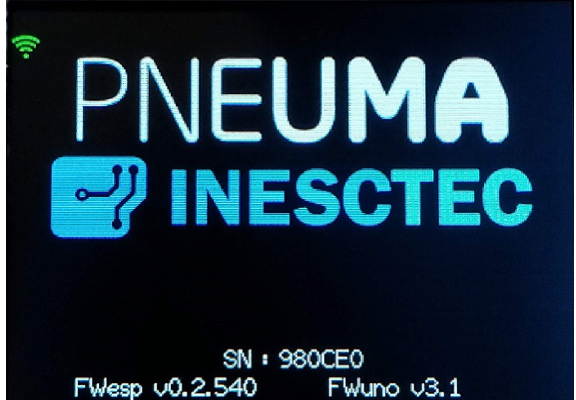
Fig. 8. Start-up information on the LCD